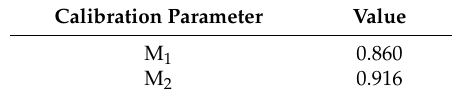
Figure 5. ( a ) Example of CCV simulation; ( b ) comparison between simulated (red solid line) and experimentally measured (black dashed line) knocking cycles percentage over 300 CCV-cycles at Full-Load without PWI. Table 4. Optimized value of the calibration parameters for the Knock